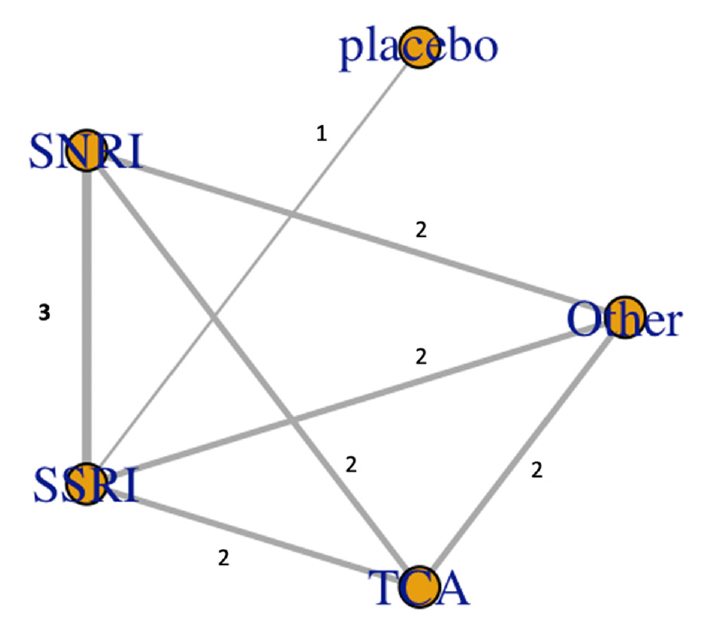
Figure 2. Network plot represented comparison among antidepressants, the network’s edge thick- ness corresponded with number of studies included (numbers on the edge are the number of included studies).